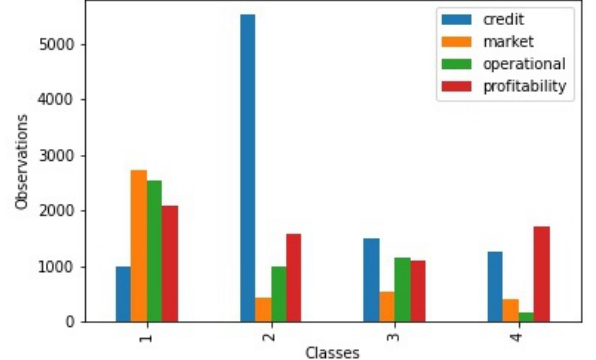
Figure 2. Number of observations in the dataset per target class, per target